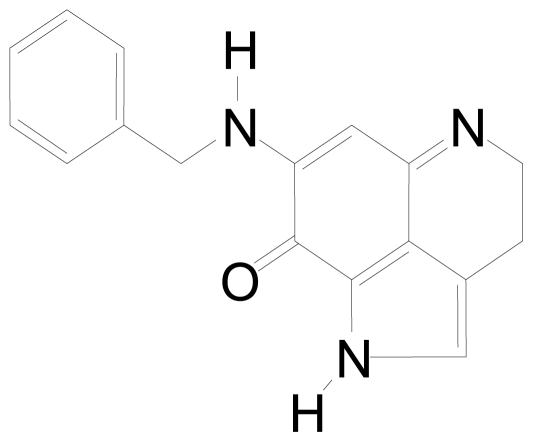
Structure of BA-TPQ.